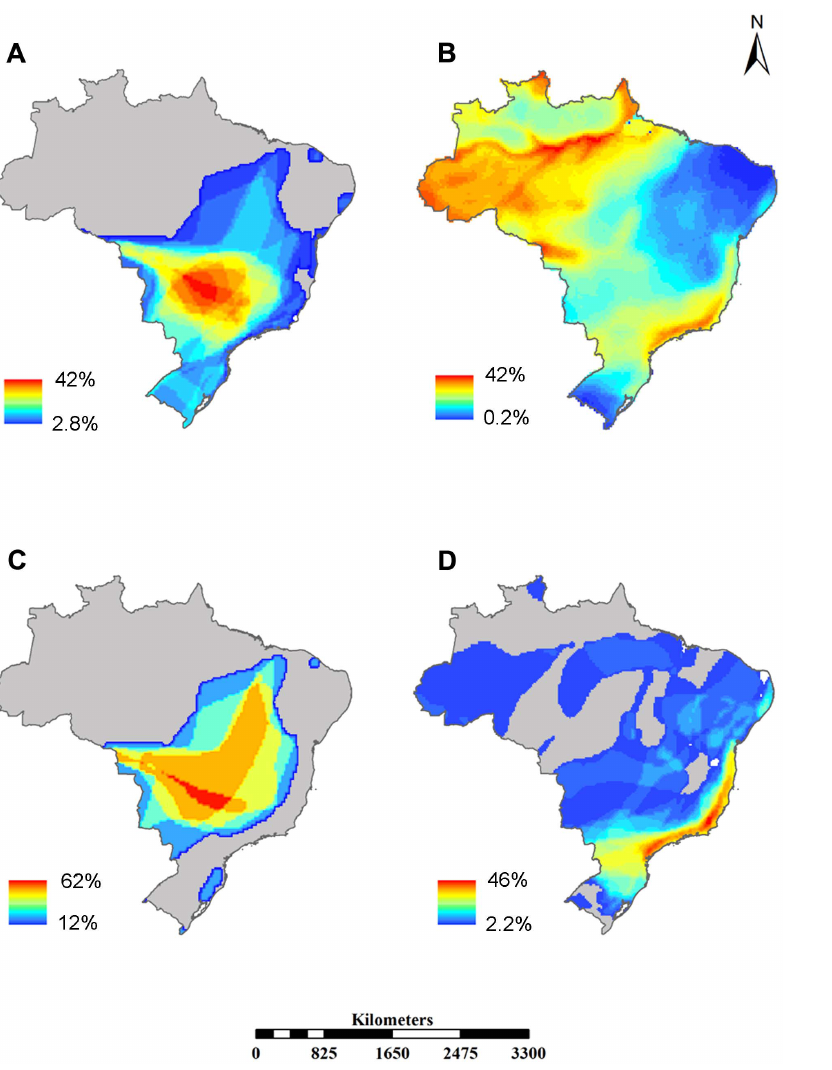
Figure 3. Spatial distribution of proportion of species for those predicted to be at high extinction risk (A), under low extinction risk (B), currently non-threatened but predicted by classification tree as threatened (C) and, currently threatened but predicted as non- threatened (D). The species richness is represented by graduated colors in the map.